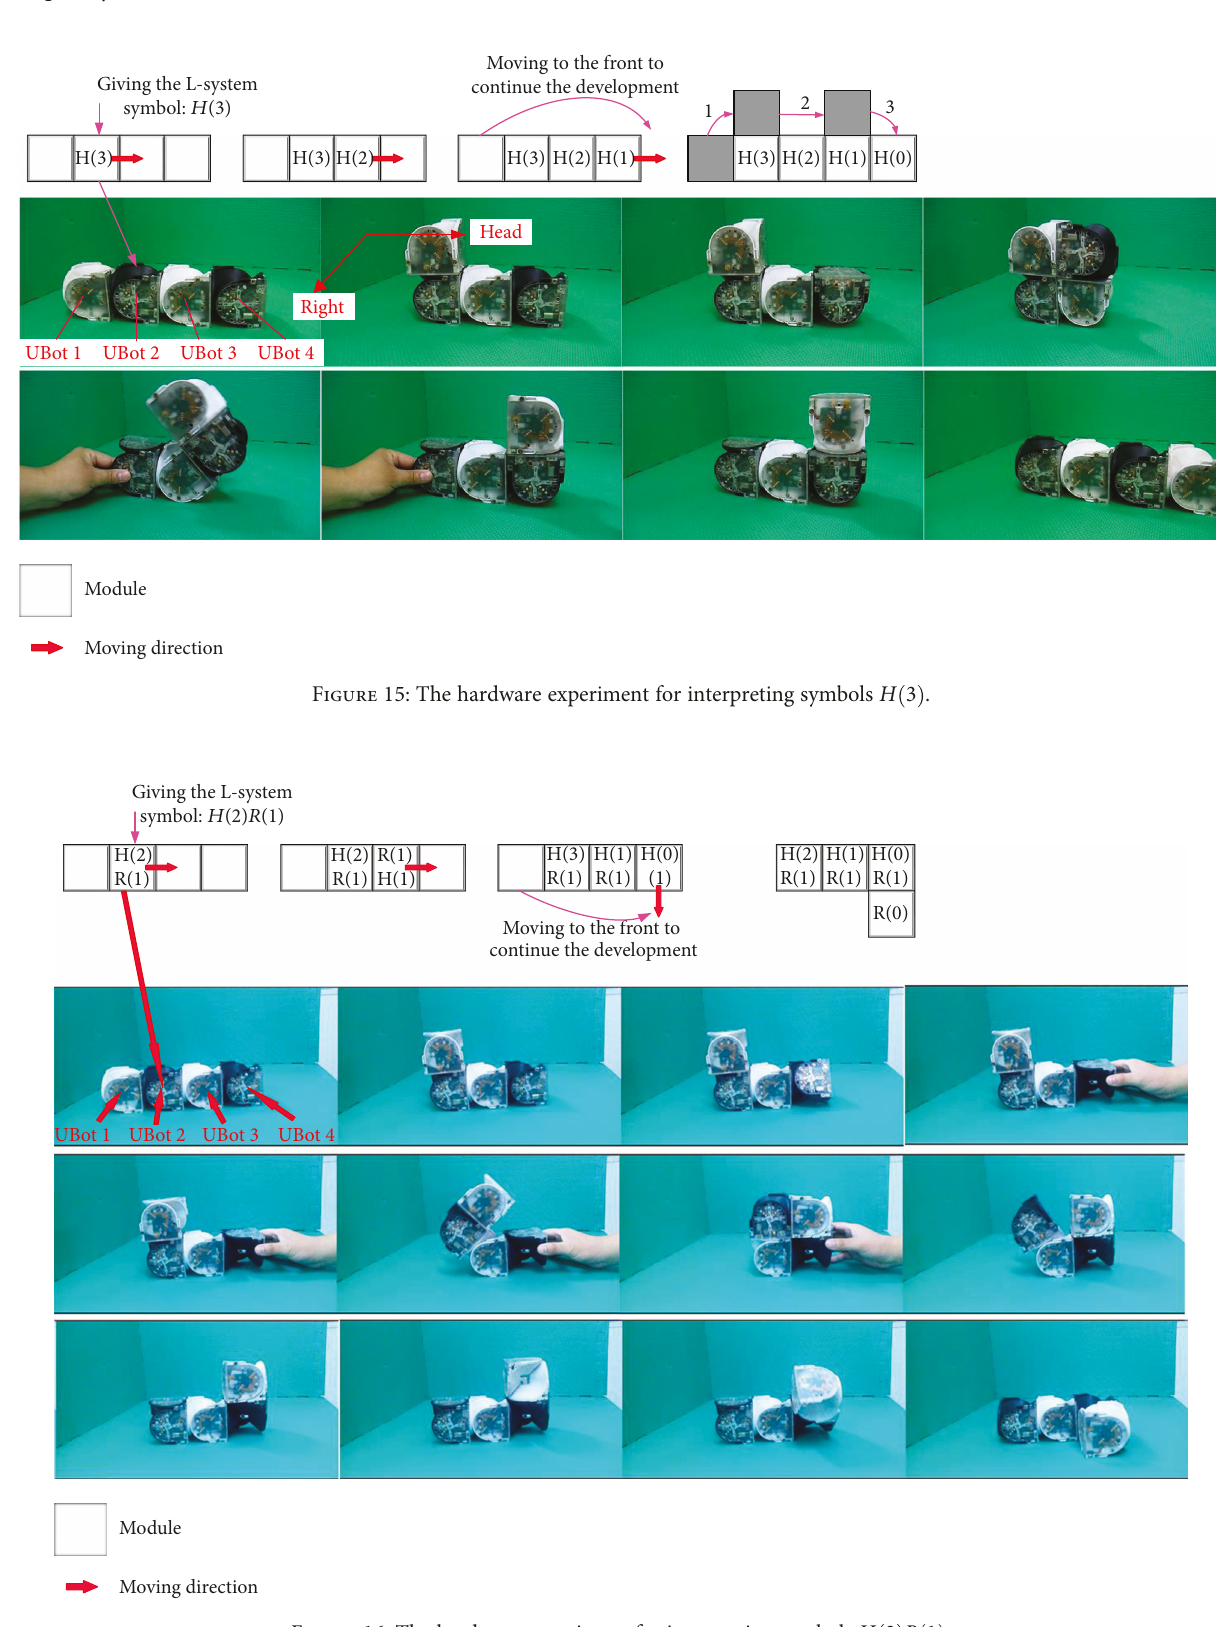
Figure 16: The hardware experiment for interpreting symbols H 2 R 1 .